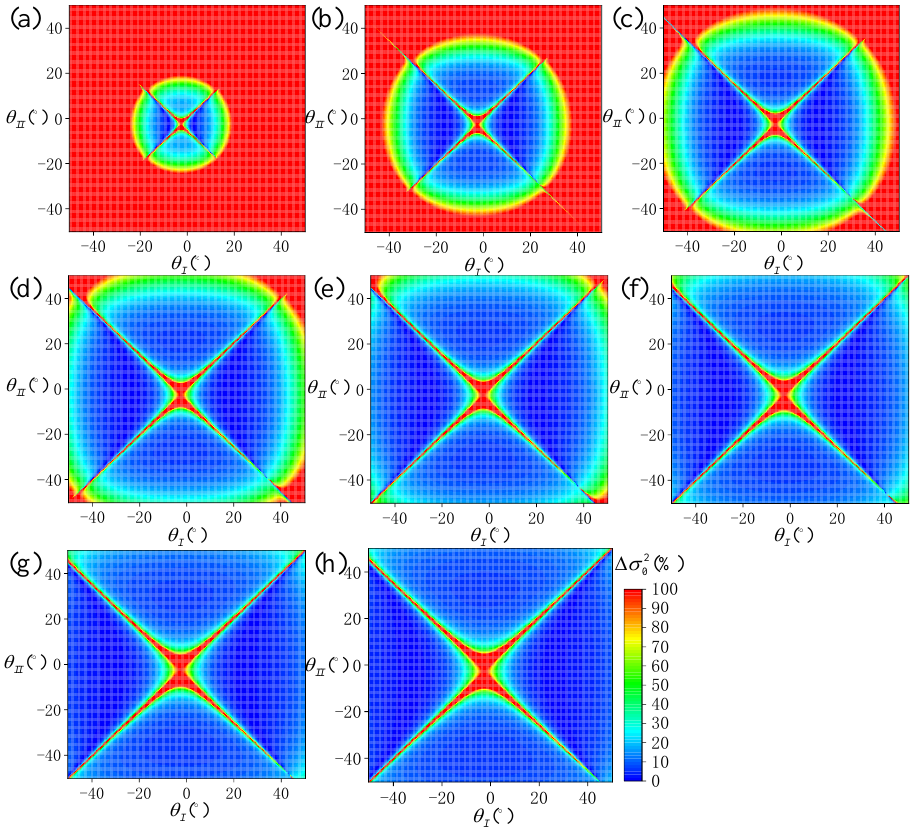
Figure 7. Distribution of SSR estimation errors ( ∆𝜎 02 ) simulated under each SVA combination ( 𝜃 𝐼 , 𝜃 𝐼𝐼 ) at different wind speeds: ( a ) W = 1 m/s, ( b ) W = 3 m/s, ( c ) W = 5 m/s, ( d ) W = 7 m/s, ( e ) W = 9 m/s, ( f ) W = 12 m/s, ( g ) W = 13 m/s, and ( h ) W = 15 m/s.